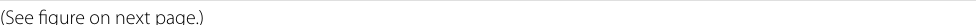
(See figure on next page.) Fig. 1 From top to bottom: components of IMF viz B x , B y and B z , B total , x-component of solar wind velocity ( v x ), solar wind density ( N sw ), temperature variation of electron flux along the IMF direction (T), as observed by WIND spacecraft, AE index, AL index, IL index, Wp index and Dst index, during 19:00–05:00 UT on 17–21 March 2015. Components of interplanetary magnetic field are plotted in GSM coordinates and the x-component of solar wind velocity is plotted in GSE coordinates. The expansion phases of five substorms associated with St. Patrick’s Day 2015 geomagnetic storm are marked with vertical dotted lines and substorm numbers are marked at the